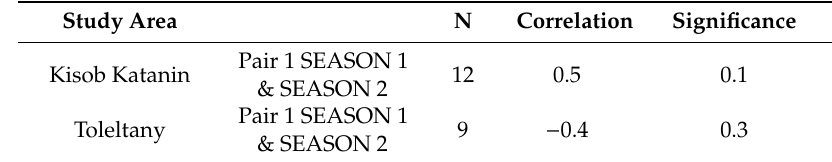
Table A9. Sample Correlations (Kilibwoni division).